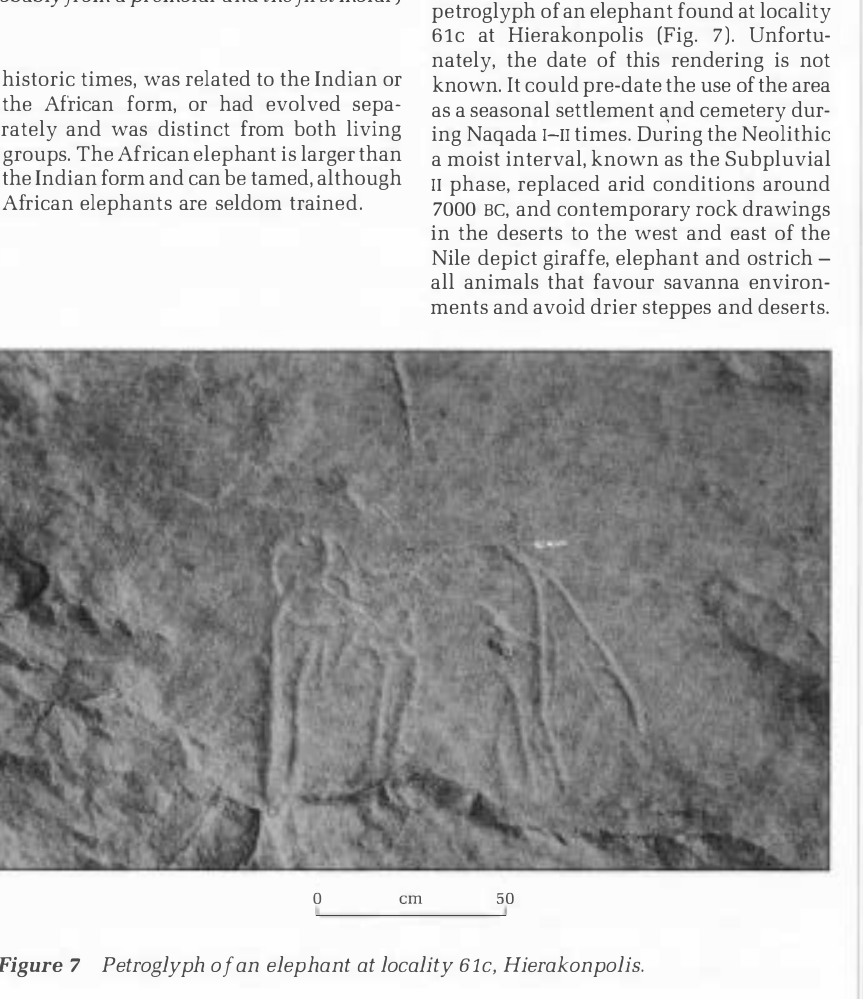
Figure 6 Three fragments of cheek teeth (probably from a premolar and the first molar) from the elephant jaw found in tomb